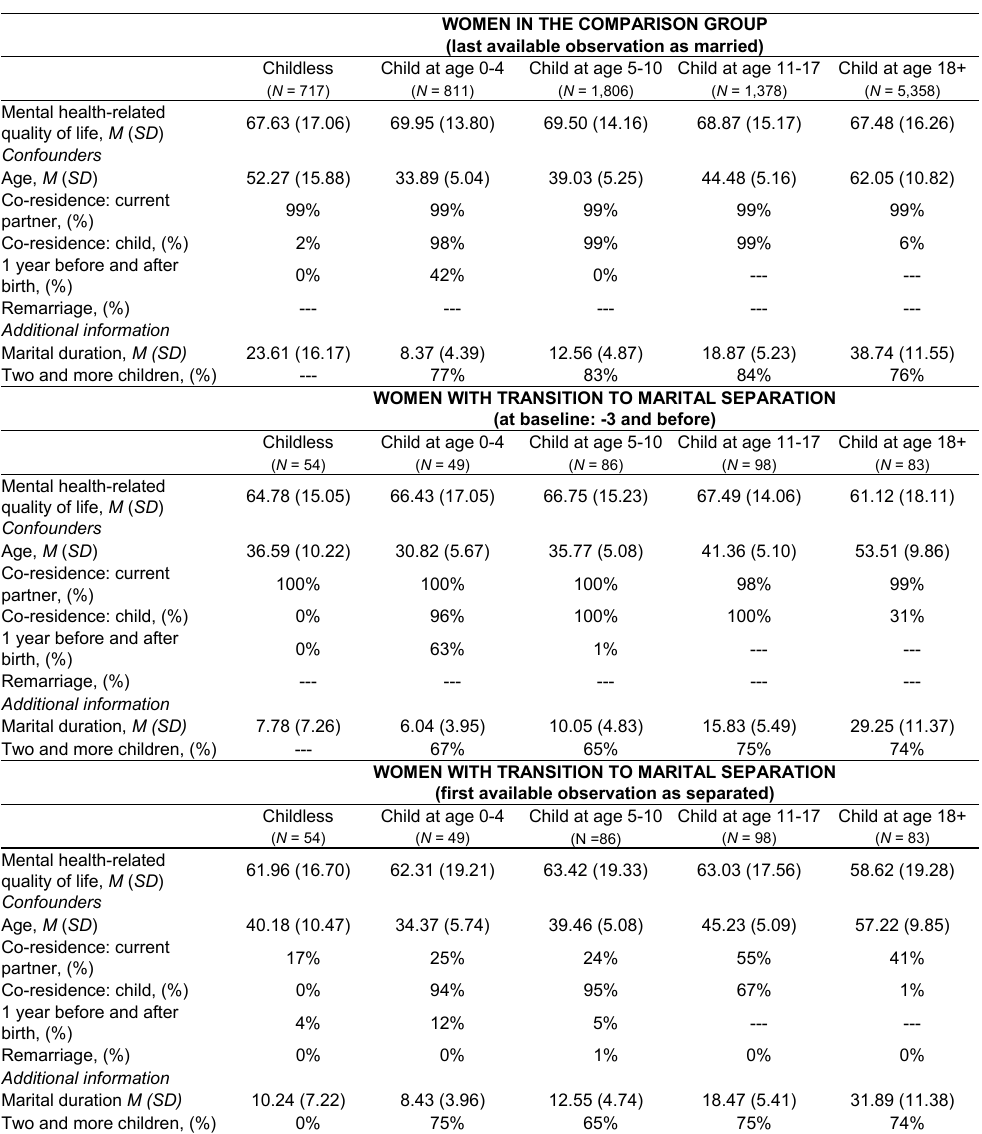
Table 1 : Sample composition by age of the youngest biological child before and after marital separation for